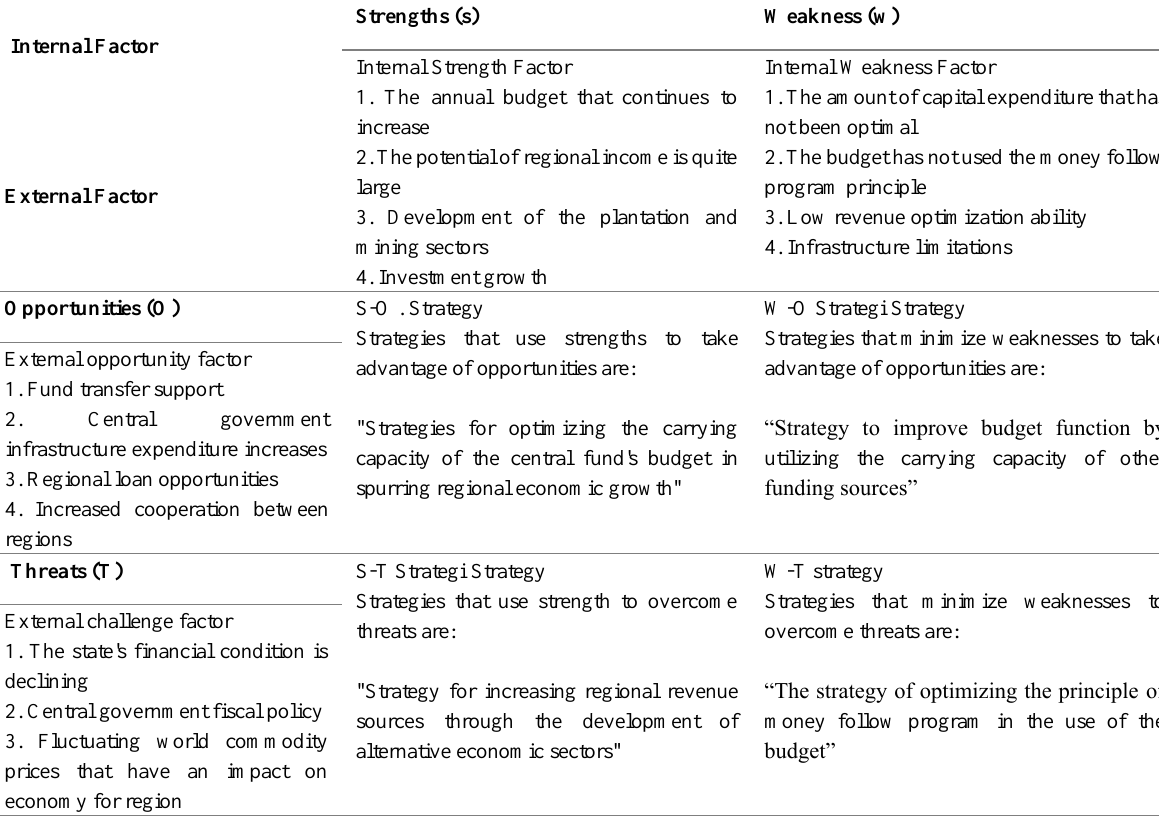
Table 1: SWOT Diagram of Regional Financial Performance